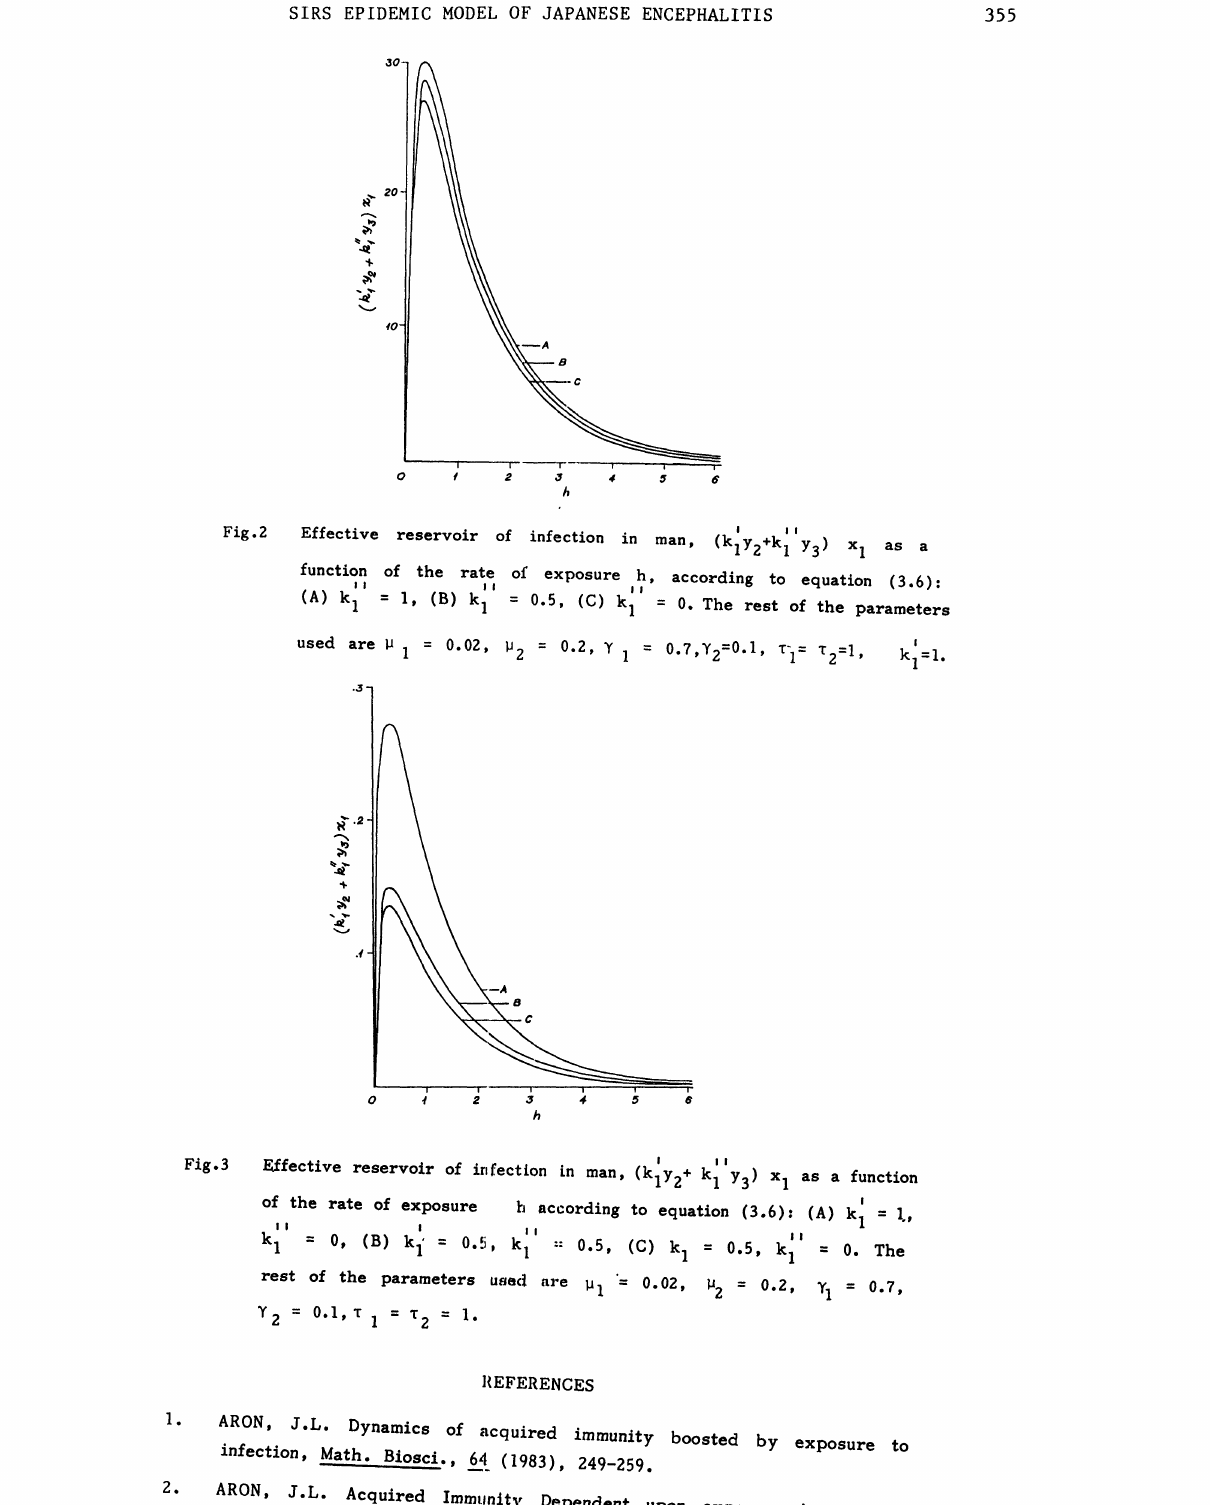
Fig.3 Effective reservoir of irfectfon in man, (klY2+ k y3) of the rate of exposure h according to equation (3.6): k 0, (B) kl’ k 0.5 (C) k 0.5 rest of the parameters ueJed are I 0.02, 2 0.2, 71 7 2 0.I, z z 2